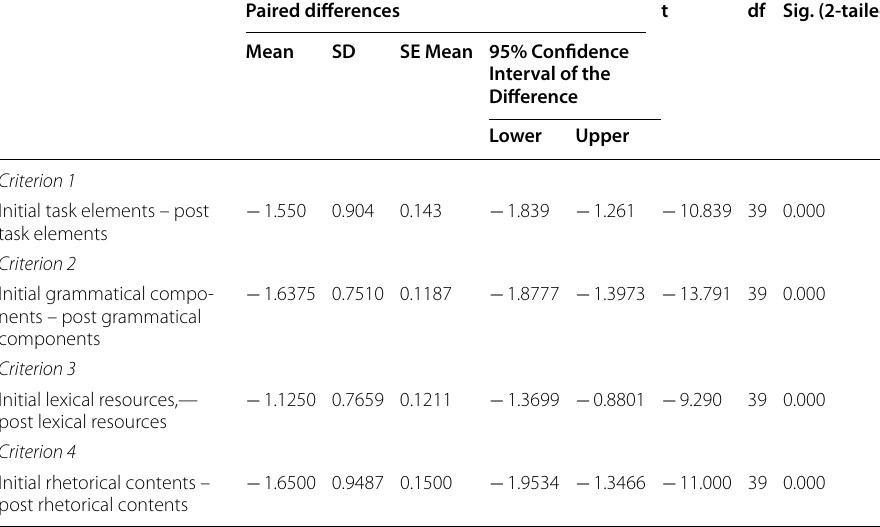
Table 3 Paired samples test for each criterion Paired differences t df Sig.